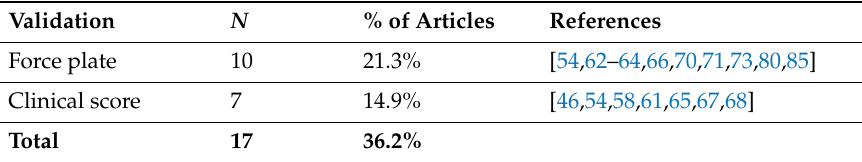
Table 6. Articles with validation against a gold standard (force plate or clinical